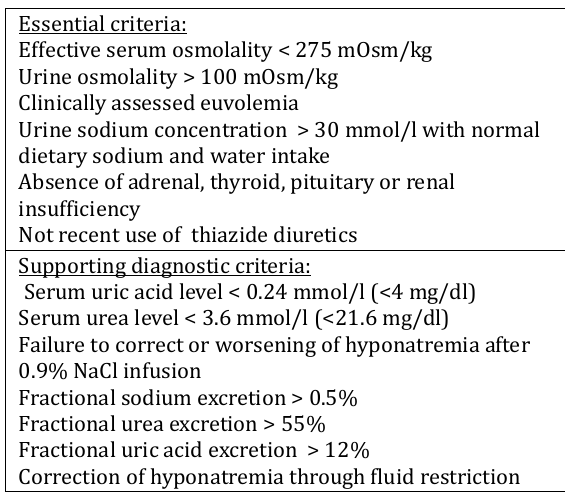
Table 4. Diagnostic criteria of SIADH (adapted from Spasovski, G. et al.) [5]